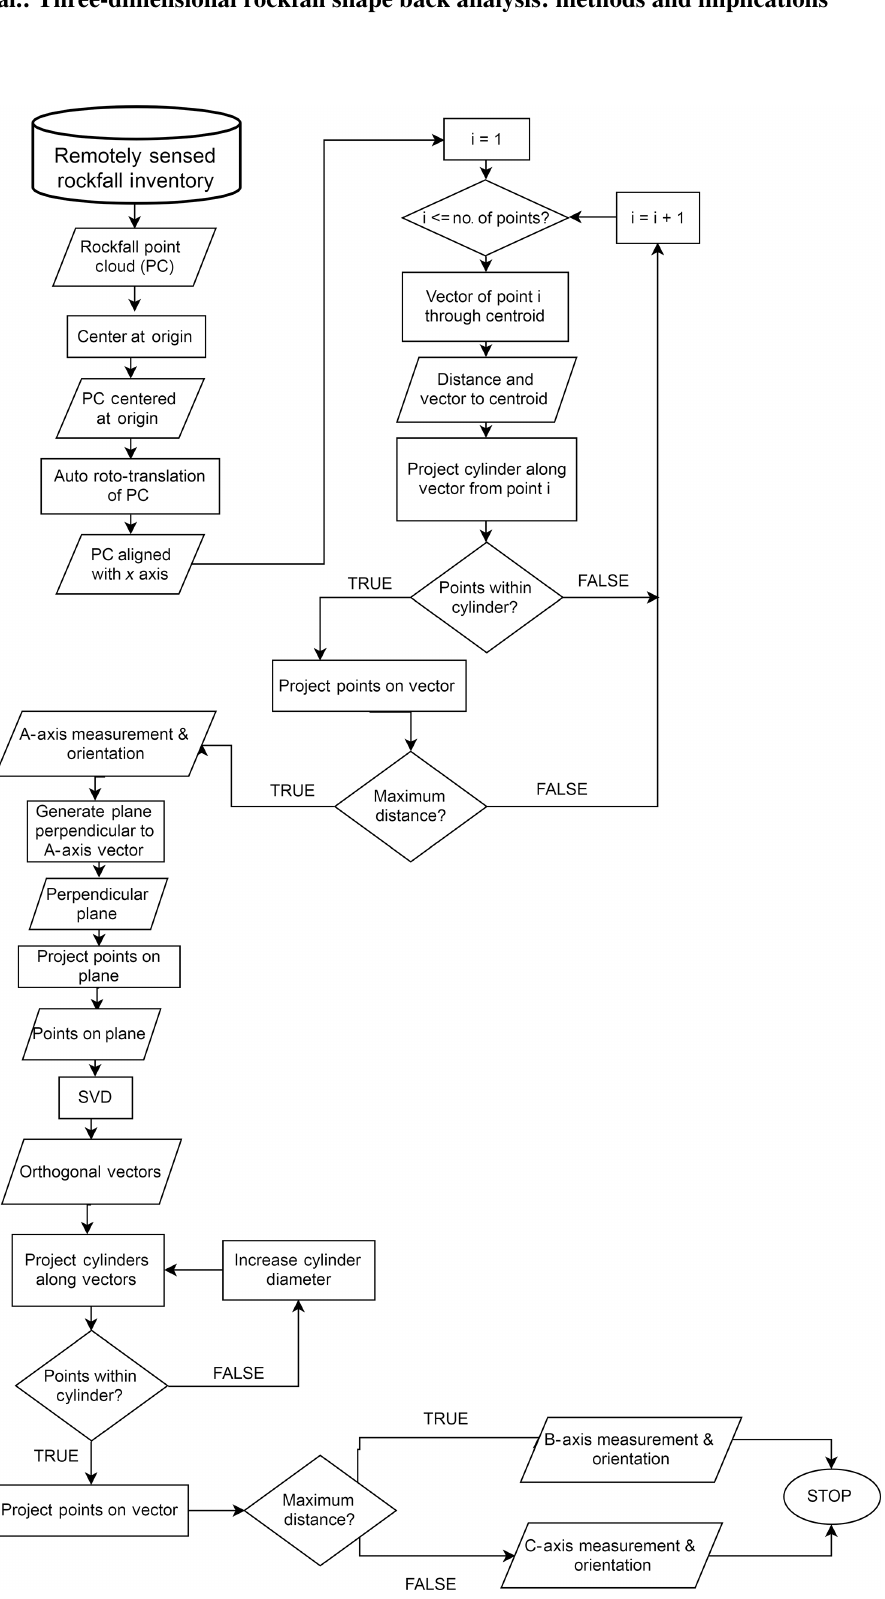
Figure 8. Structured flow chart of the RFCYLIN